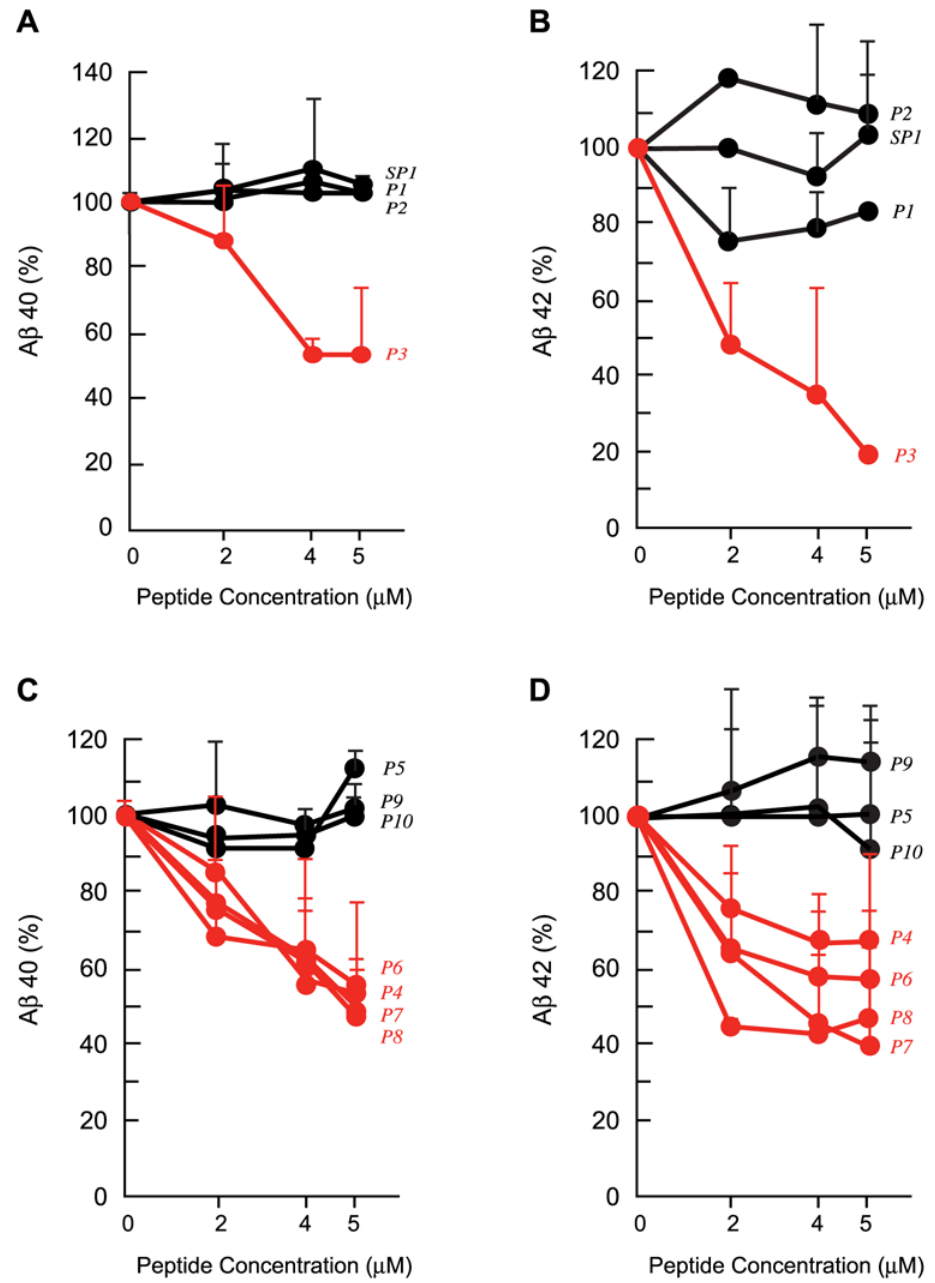
Fig 1. Effects Of Peptides P1 Through P10 On A β 40 and 42 Production In Vitro . A and B. Peptides P1 (residues 1 – 80 of PS-1), scrambled P1 (SP1), P2 (residues 1 – 40 of PS-1) and P3 (residues 41 – 80 of PS-1) (0 – 5 μ M) were added to cultures of IMR-32 cells for 24 h and the culture media were analysed for A β 40 (A) and A β 42 (B) by ELISA. A β levels in pg/ml were expressed as a percentage of levels observed in the absence of added peptide. Values represent group means of 3 – 4 independent experiments per peptide ± s.e. m. Only P3 produced a clear dose-dependent decrease in both A β 40 and -42, shown in red. C and D. Overlapping peptides from the P3 region (P4 – P10) (0 – 5 μ M) were next tested in IMR-32 cultures as in A and B above for their effect on A β 40 (C) and -42 (D) production. A family of peptides, P6, P7 and P8 and an independent peptide, P4, produced substantial dose-dependent reduction in A β 40 and 42, shown in red.